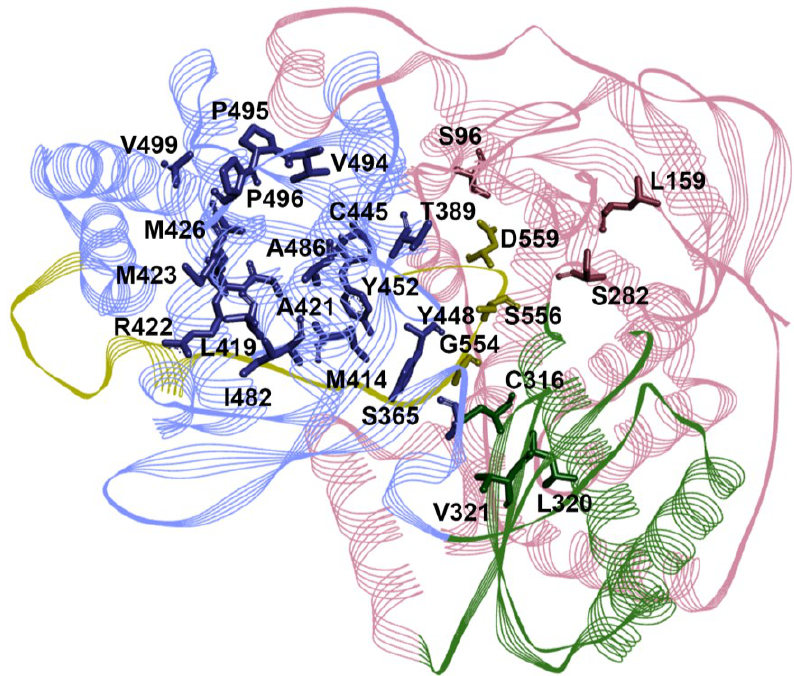
Figure 3. Positions of RdRp residues associated with resistance to HCV nucleoside (NI) and non-nucleoside inhibitors (NNI).The secondary structure of the HCV GT1b polymerase is coloured as in Figure 1, shown with the palm domain facing away. Known residues where substitutions confer resistance to NIs and NNIs are highlighted (Table